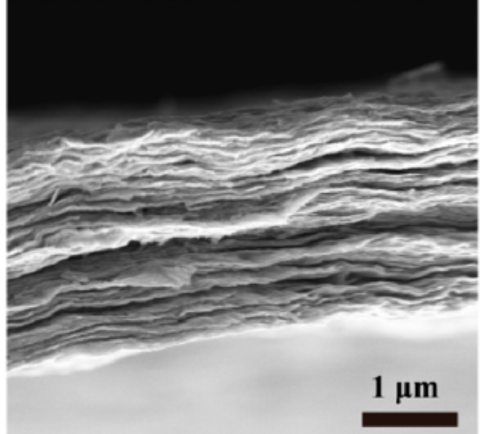
Figure 1. Scanning electron microscopy image: layer morphology of CTF [39]. Reprinted with permission from JACS, 2017, 139, 11666. Copyright 2022 American Chemical Society.